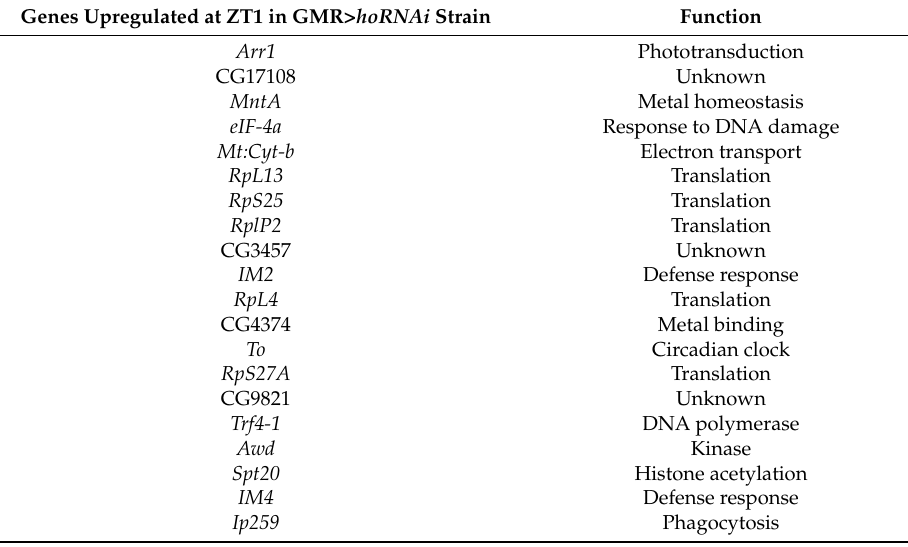
Table 4. Top 20 genes up- and downregulated after ho silencing in photoreceptor cells at ZT1. Genes Upregulated at ZT1 in GMR> hoRNAi